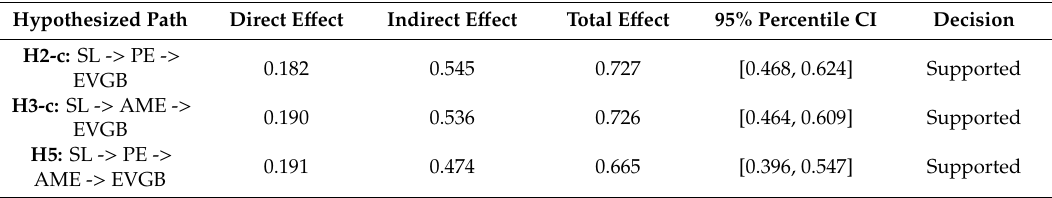
Table 6. Results of the mediation